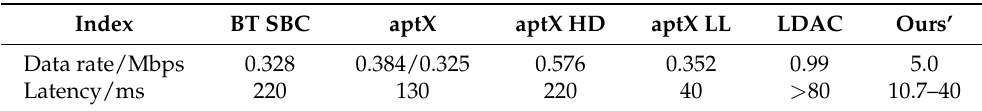
Table A1. Over-the-air data rate and audio latency performance comparison between our wireless audio transmission system and various Bluetooth-based